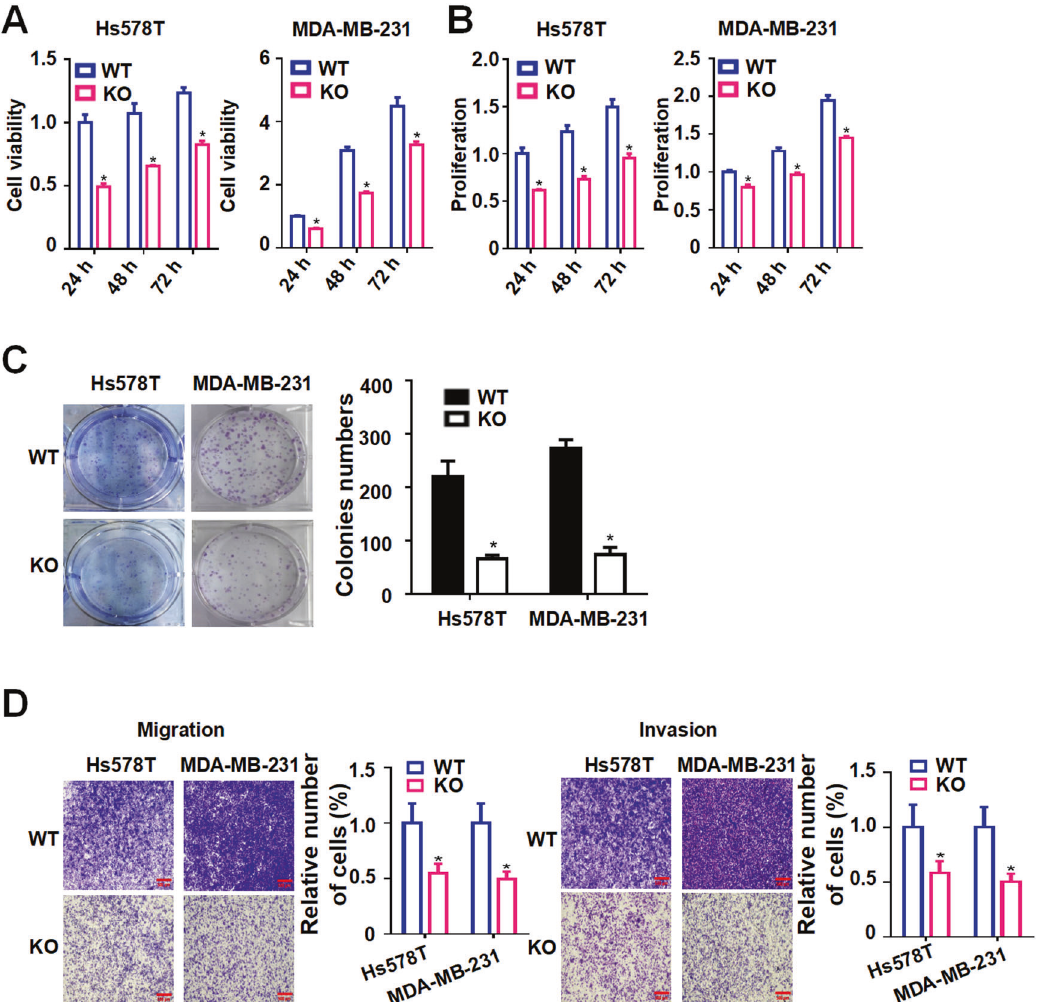
Fig. 7 TMEM97 knockout reduces cell viability, proliferation, colony formation, migration and invasion in breast cancer cells. TMEM97 knockout Hs578T and MDA-MB-231 cells (KO) and their parental counterparts (WT) were seeded at 1×10 3 cells/well in 96-well plates. After 24 h, 48 h, and 72 h of culture, MTT assay was used to detect cell viability ( A ). Cell proliferation was detected using BrdU incorporation assay ( B ). C Colony formation of TMEM97 knockout Hs578T and MDA-MB-231 cells (KO) and their parental counterparts (WT). The right panel is the diagrammatic representation of quantitative data which showed the relative number of colonies formed in knockout cells and their parental counterparts at day 10. The number of colonies was calculated by the ImageJ software ( n = 3). (D) Knockout of TMEM97 blocked the migration and invasion of Hs578T and MDA-MB-231cells. The right panel is the quantitative data on the relative number of migrated or invaded cells in the graphs ( n = 3). Scale bar = 500 μ m. Data were shown as mean ± SD. * P < 0.05 compared with vehicle